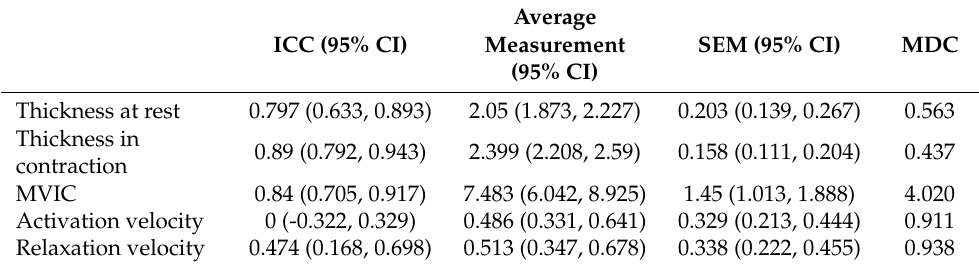
Table 3. Inter-observer